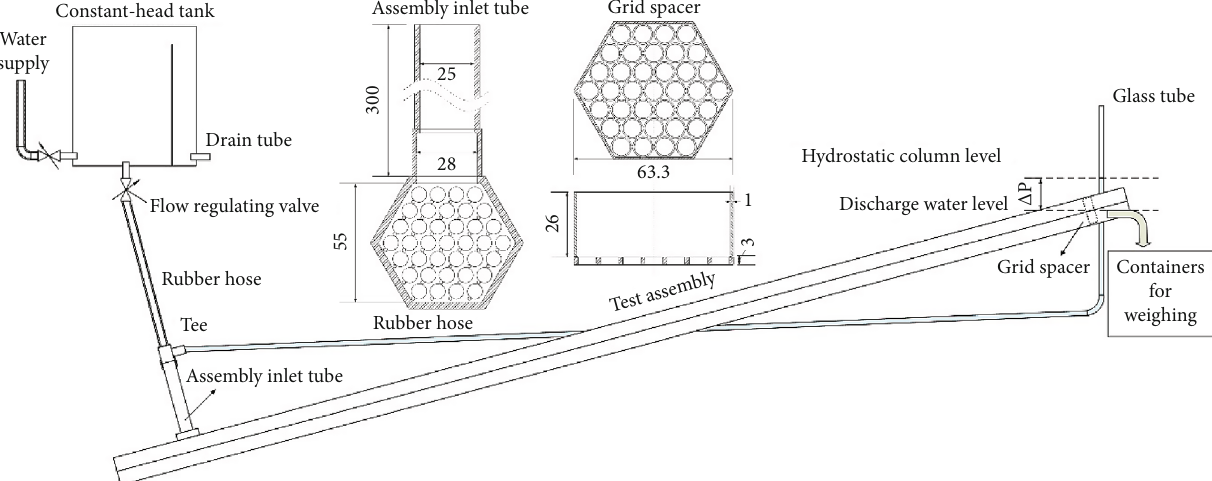
Figure 1: Experimental